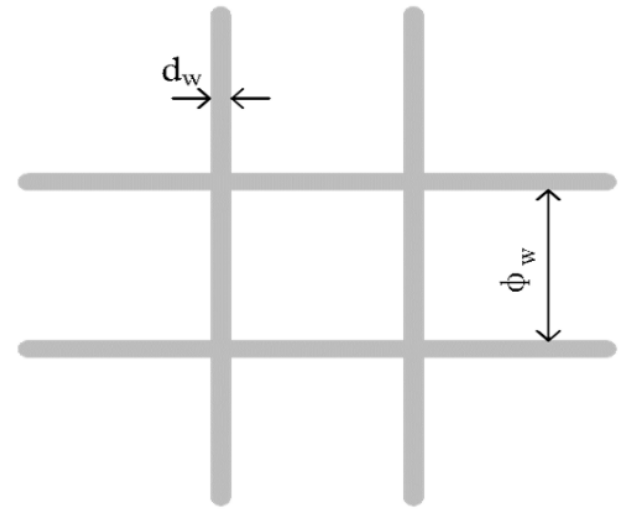
Figure 1. Schematic of stainless steel mesh.